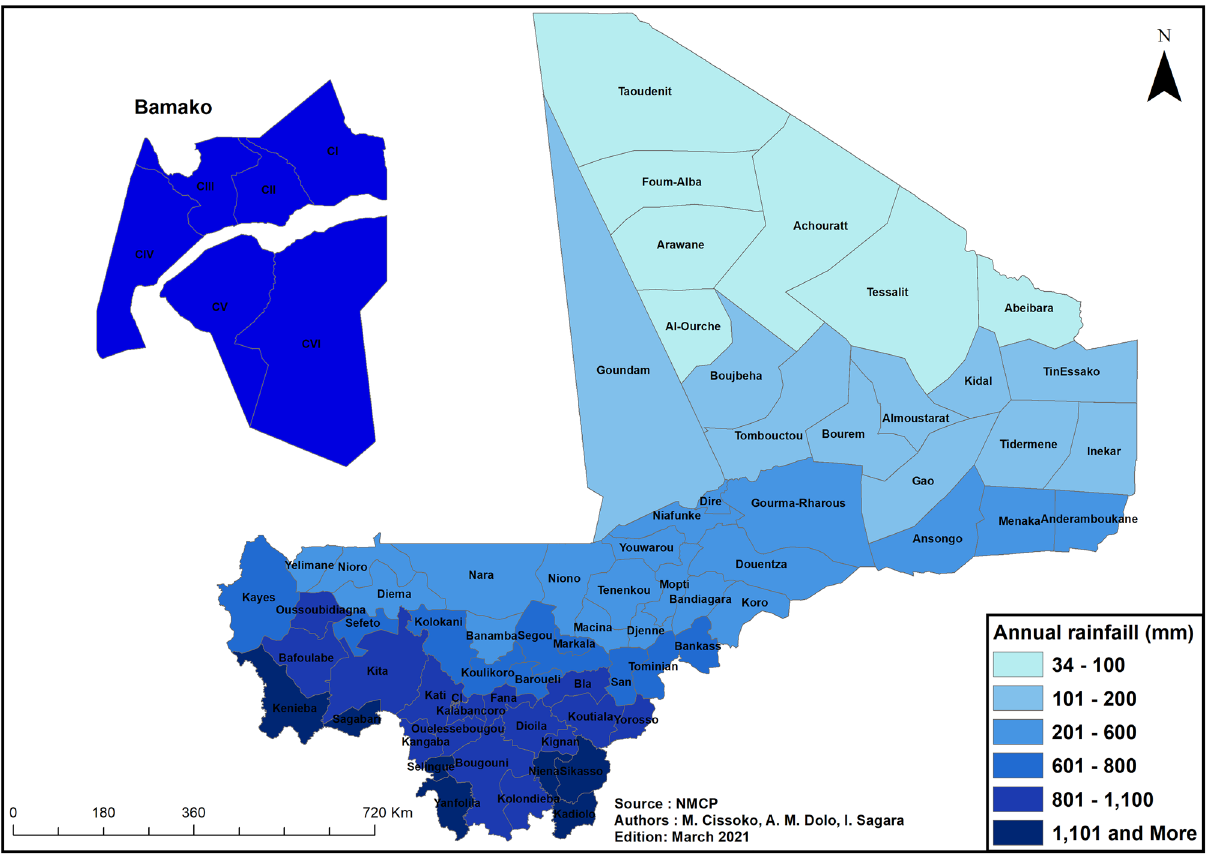
Figure 6. Map of average annual rainfall by health district, Mali, 2017–2019. ArcGIS Desktop version 10.8 software (Environmental Systems Research Institute (ESRI), 380 New York Street, Redlands, CA 92373-8100, USA, https:// www. esri.